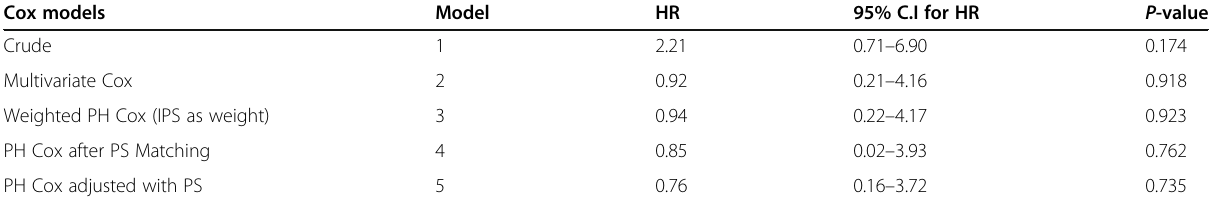
Table 3 The effect of statin use on COVID-19 patient survival as assessed by the crude, multivariable and propensity score analysis Cox models